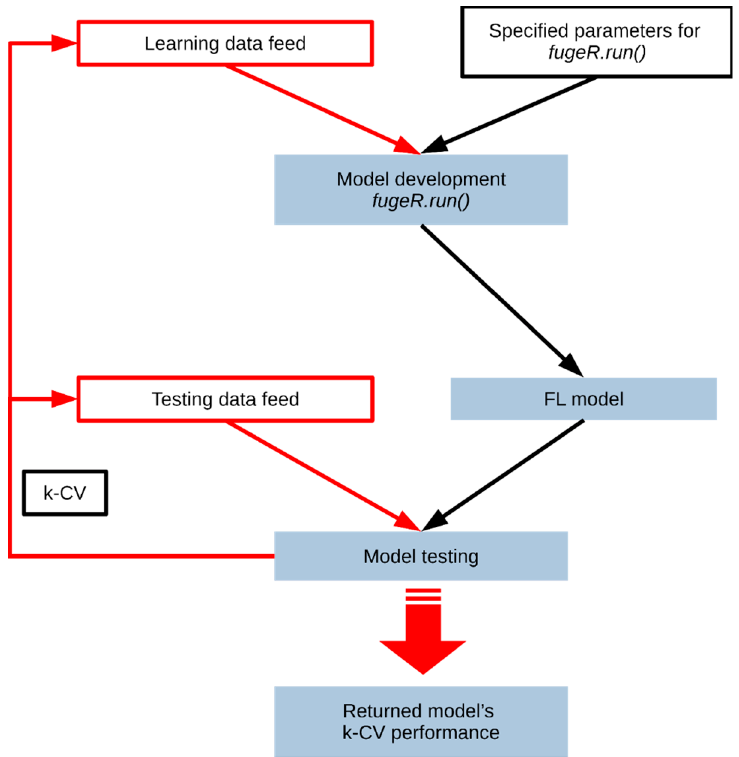
Figure 1. The workflow of in-house developed software implementing fugeR framework to model development and assessment system using fuzzy logic (FL) coupled with evolutionary algorithms. Software controls: data feed and model development process returning results in structured reports [18].